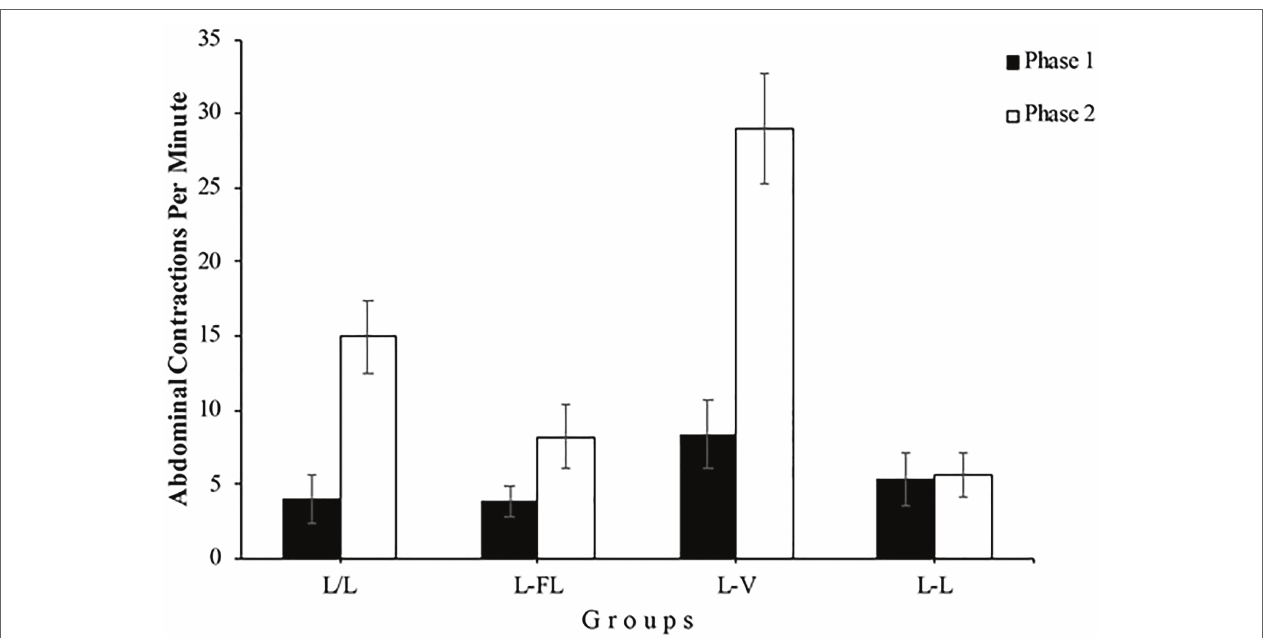
FIGURE 3 | Mean abdominal contractions during the last minute of Phase 1 (black bars) and the first minute of Phase 2 (white bars) of Experiment 1. Error bars denote standard errors of the